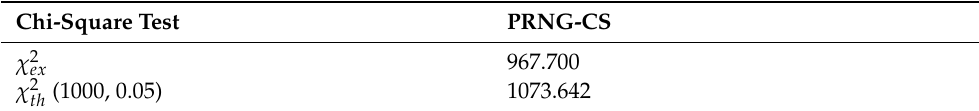
Table 4. Chi-square results on the tested histograms. Chi-Square